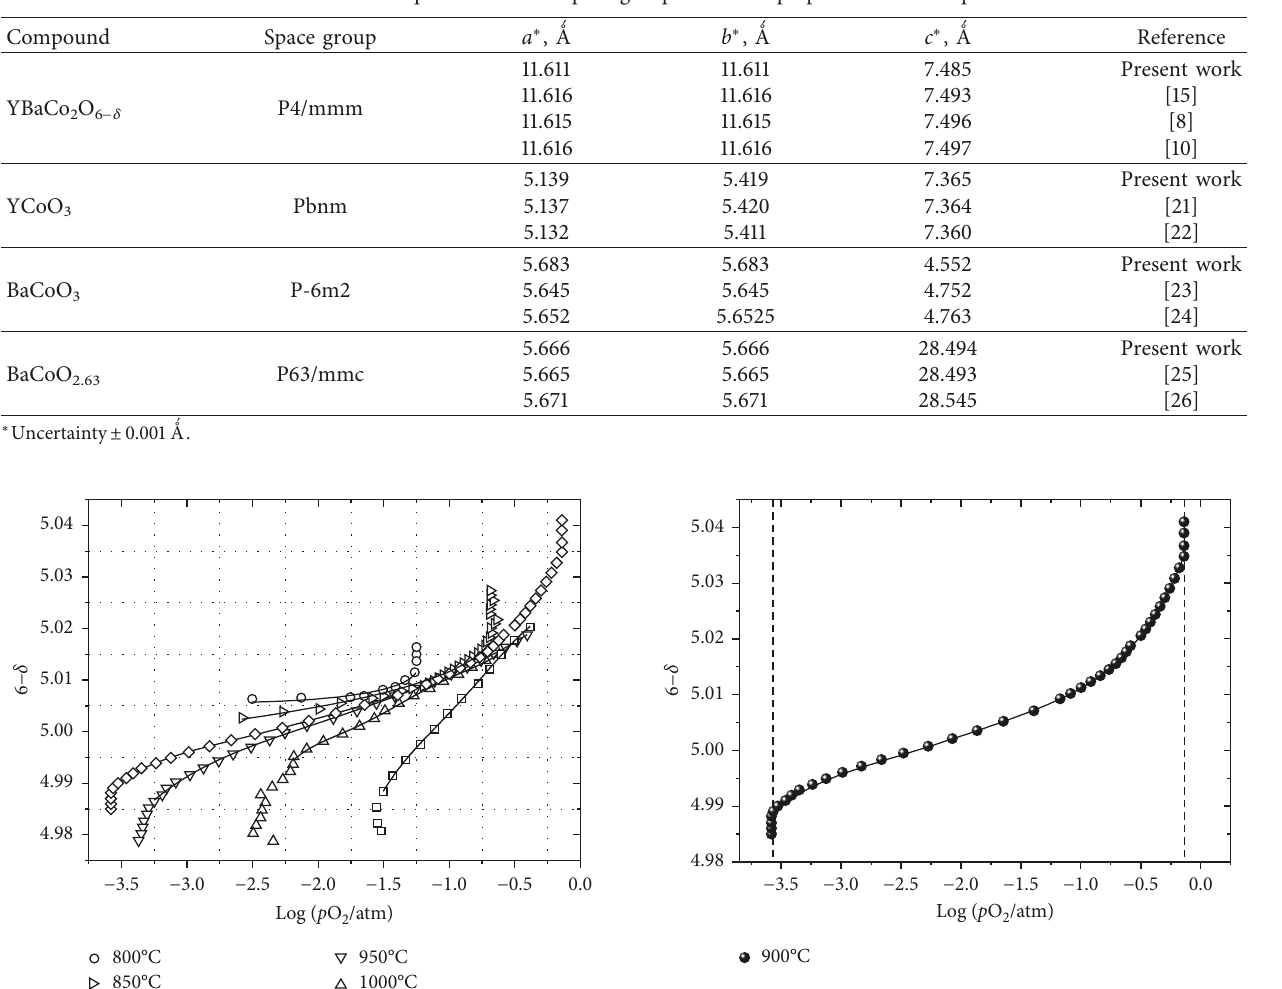
Figure 5: Oxygen content, 6 900 ° C. Points correspond to experimental data and line is guide to δ , in YBaCo 2 O 6 eye δ versus p O 2 at − − Thermodynamic stability limits of YBaCo 2 O 6